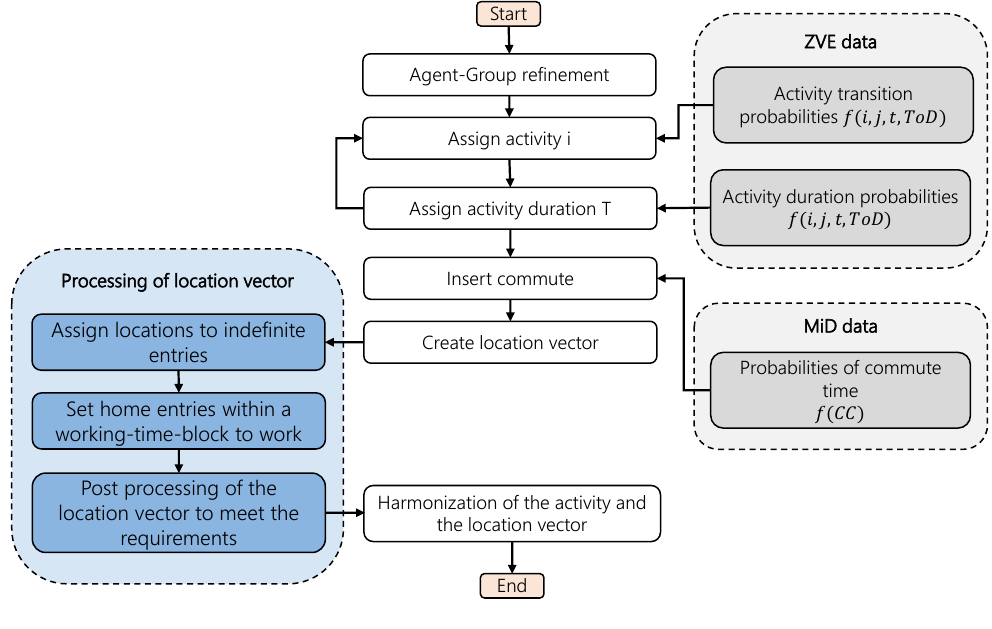
Figure 2. Flowchart of the activity